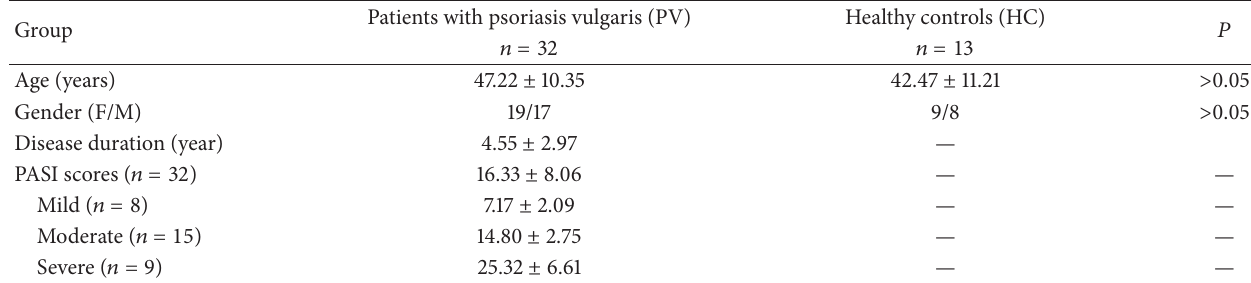
Table 1: Clinical characteristics of